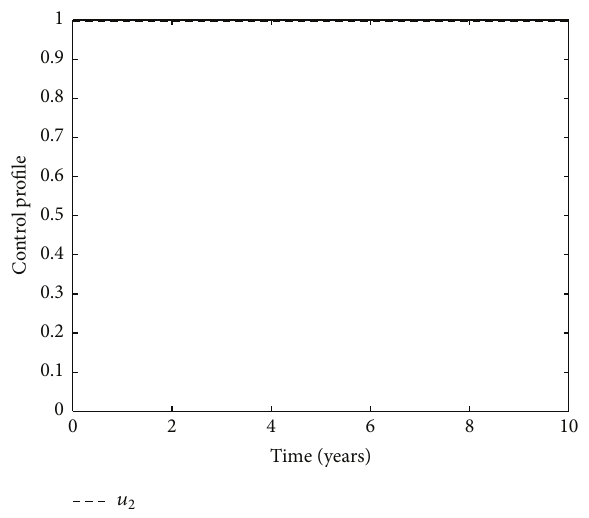
Figure 9: The profile of the optimal ARV control 𝑢 ∗ 2 .